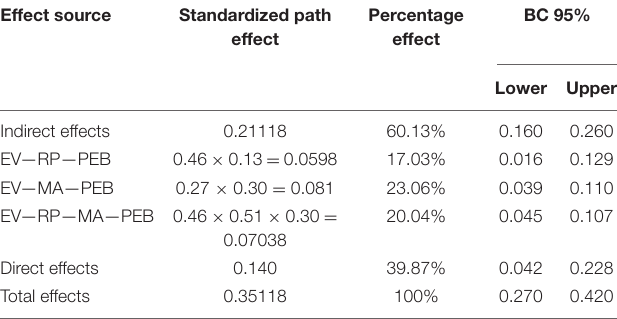
TABLE 2 | Direct, indirect and total effects † of the SEM components depicted in Figure 2